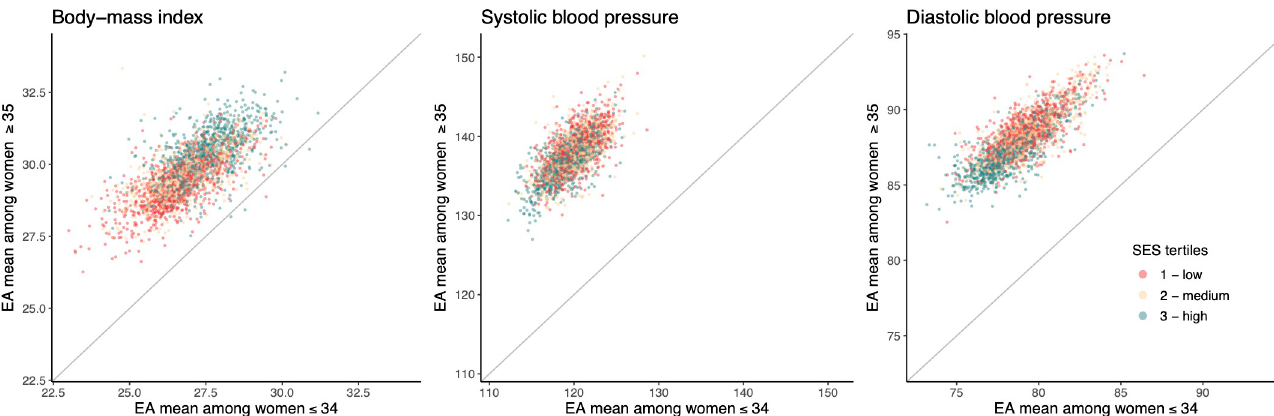
Fig 4. Relationship between mean EA BMI (kg/m 2 ), SBP (mm Hg), and DBP (mm Hg) for women younger than 35 years and those 35 years and older in Accra in 2010. The position of each point along the x-axis and y-axis represents the mean BMI or BP among women in each age group within each EA. The colours of the points represent tertiles (33% increments) of mean EA relative SES based on household assets of women in the census. The SES measure, based on the first principal component (PC 1), was used as described in Methods. BMI, body-mass index; BP, blood pressure; DBP, diastolic blood pressure; EA, enumeration area; PC 1, principal component 1; SBP, systolic blood pressure; SES, socioeconomic